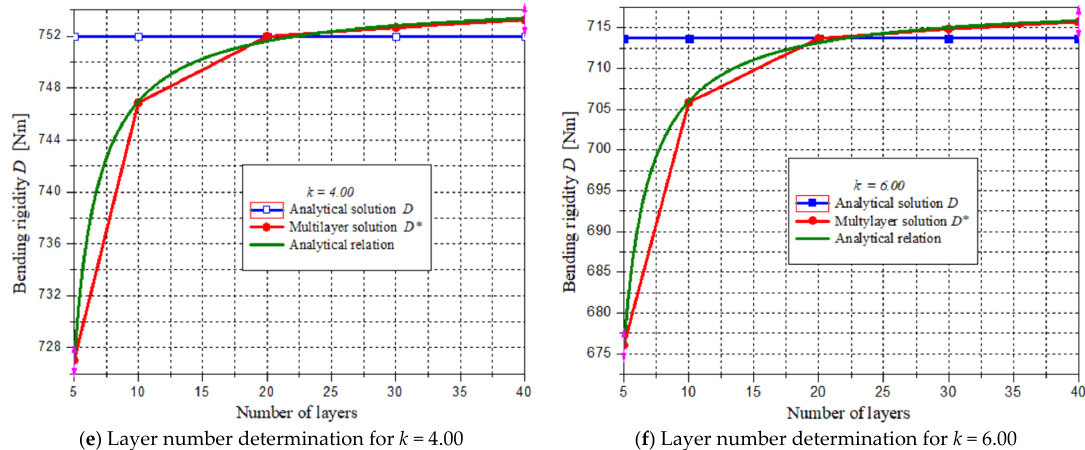
Figure 10. Graphical determination of the layers number for some k values. Table 6. Analytical relations and their results.